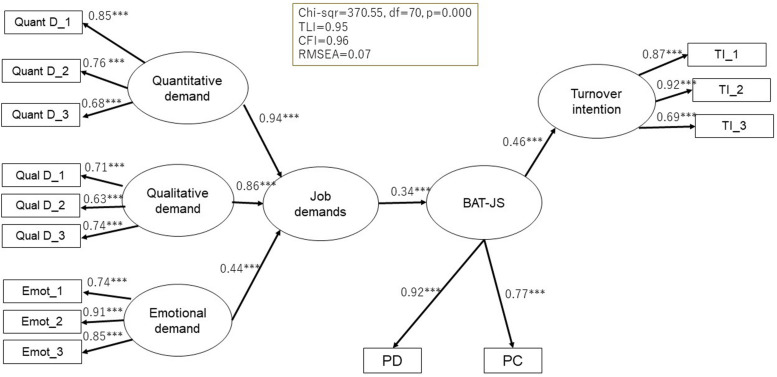
Standardized solution (Maximum Likelihood estimates) of the hypothesized model of the relations of BAT-JS with potential antecedents and consequences (N = 982). Quant D, quantitative demand; Qual D, qualitative demand; Emot, emotional demand; TI, Turnover intention. ***p < 0.001.